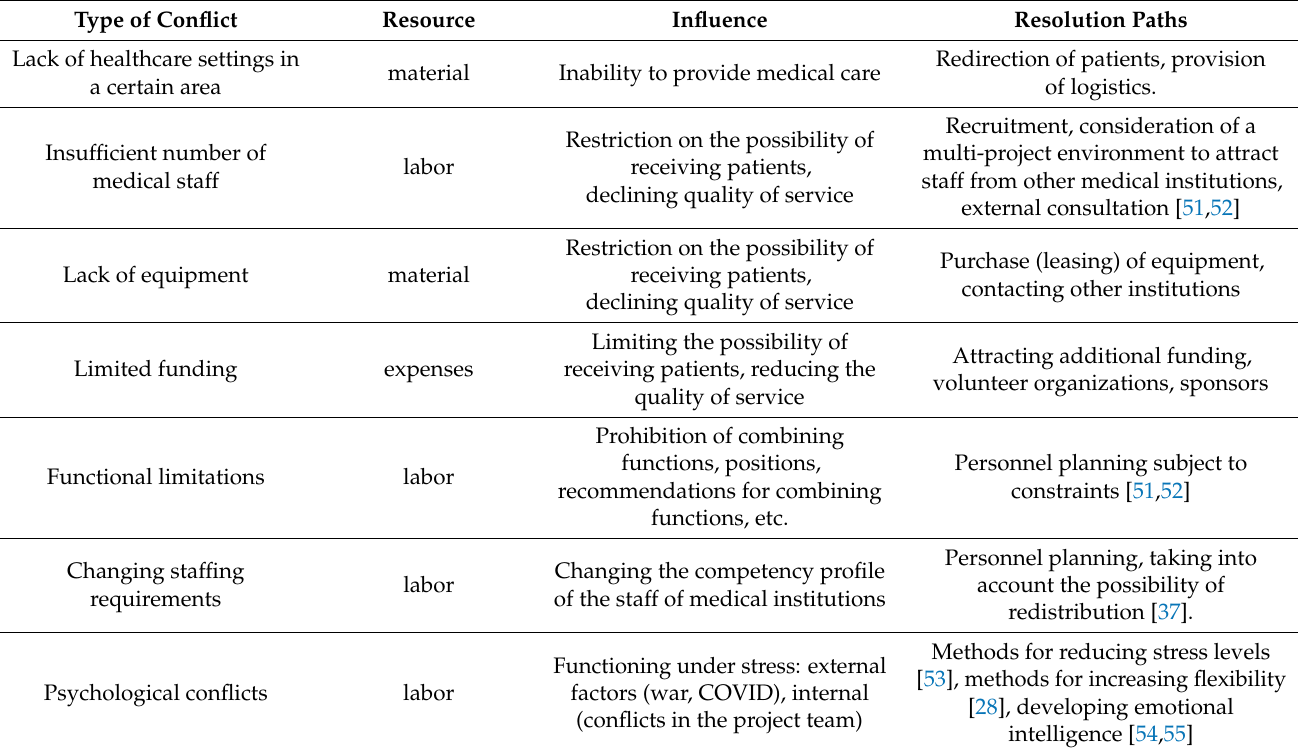
Table 3. Resource conflicts arising in healthcare